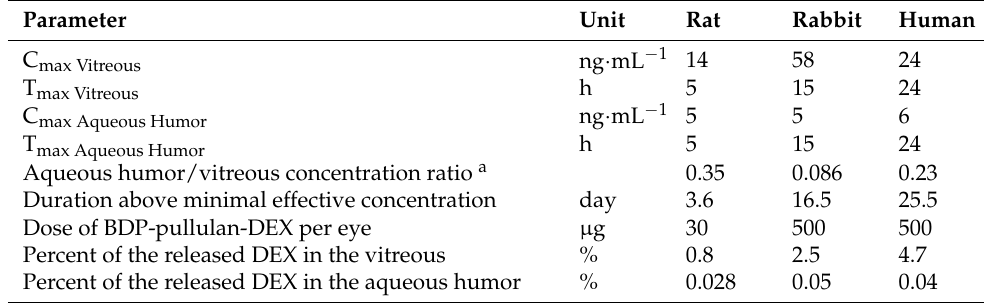
Table 3. Pharmacokinetic parameters of dexamethasone derived from simulations of intravitreally injected BDP-pullulan-DEX to rat, rabbit and human eyes. The dose of dexamethasone was 3, 50 and 50 µ g per eye for rats, rabbits and humans,